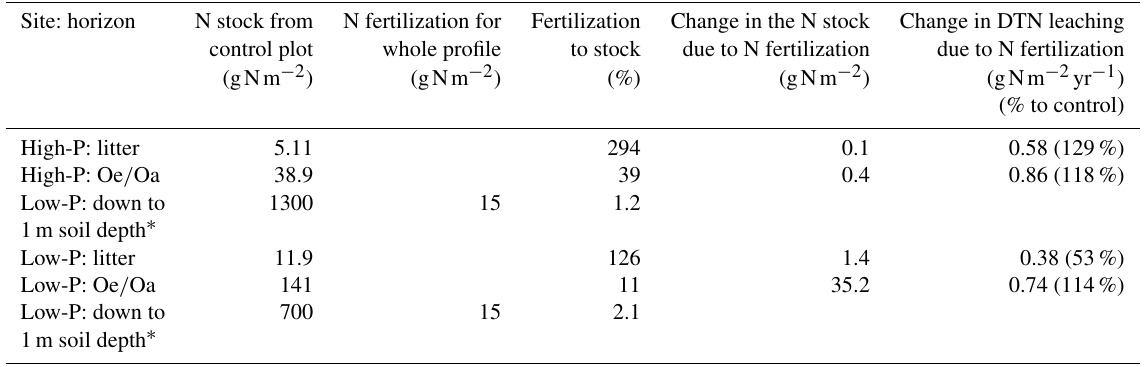
Table 6. Soil nitrogen (N) stocks from the control plots ( n = 3) at the high-P and the low-P site for the litter and the Oe / Oa horizon, as well as added amounts of N, and the change in annual leaching of dissolved total N (DTN) and in element stocks due to fertilization. Other treatments are given in Sect.